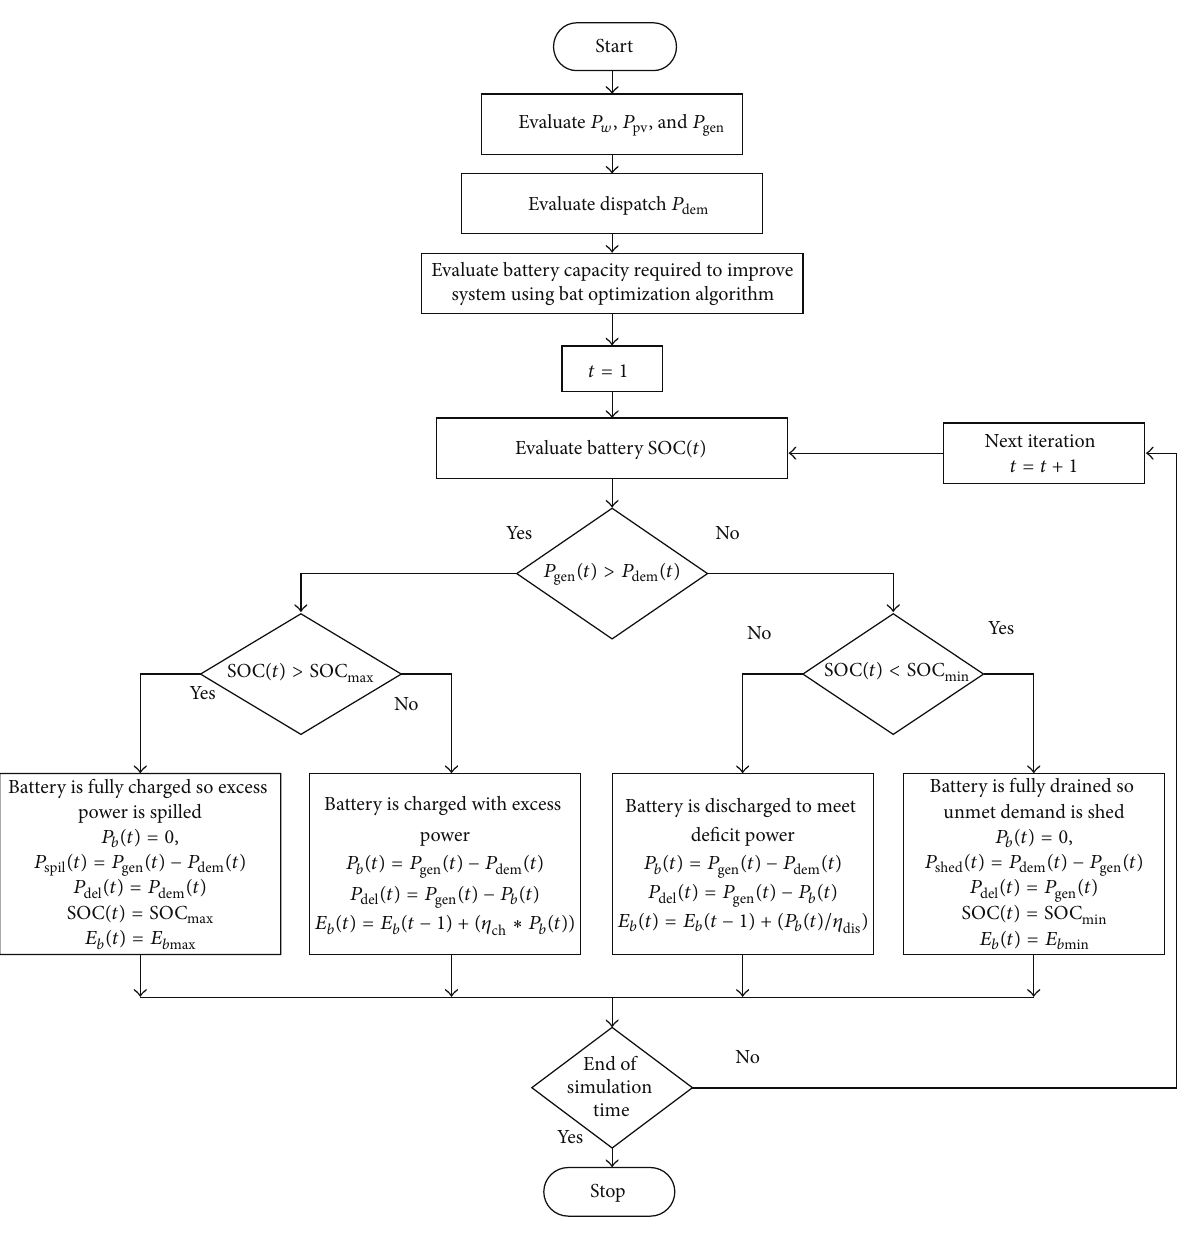
Figure 6: Energy management